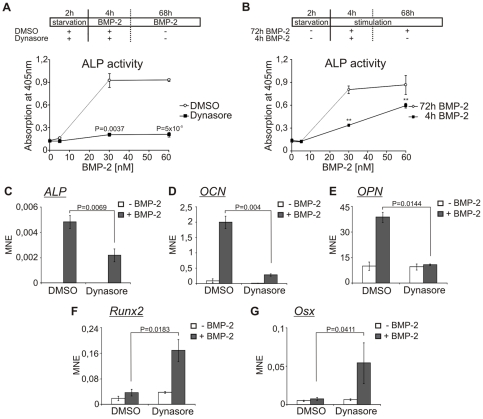
Osteoblast differentiation is arrested by inhibition of dynamin-dependent endocytosis.(A,B) Confluent C2C12 cells were serum-starved for 2 h prior to stimulation with the indicated concentrations of BMP-2. After 72 h of stimulation, cells were lysed and ALP activity was measured at 405 nm by conversion of para-nitrophenylphosphate. A schematic representation of the treatment is depicted above the respective histogram. The histograms show mean ± s.d. of triplicate measurements representative of three independent experiments. (A) During starvation and initial 4 h of stimulation, 40 µM dynasore or 0.05% DSMO were added. (P-values in relation to control treated samples). (B) After 4 h of stimulation, BMP-2-containing medium was replaced by medium without BMP-2. (** P-values in relation to unstimulated samples; 30 nM: P = 0.008, 60 nM: P = 0.0017) (C–G) Confluent C2C12 cells were treated as described in (A) with 30 nM BMP-2. Total RNA was isolated, cDNA was synthesized and mRNA expression was analyzed by qPCR using specific mouse primers (Table S1). Histograms show mean normalized expression (MNE) with standard error of duplicate measurements relative to the housekeeping gene GAPDH. The results are representative of three independent experiments.